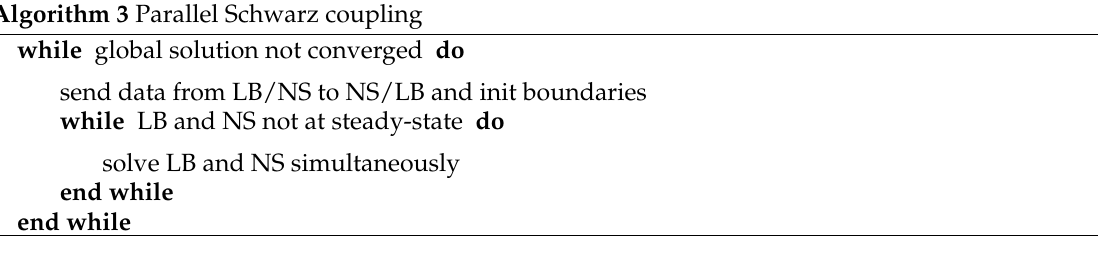
Algorithm 3 Parallel Schwarz